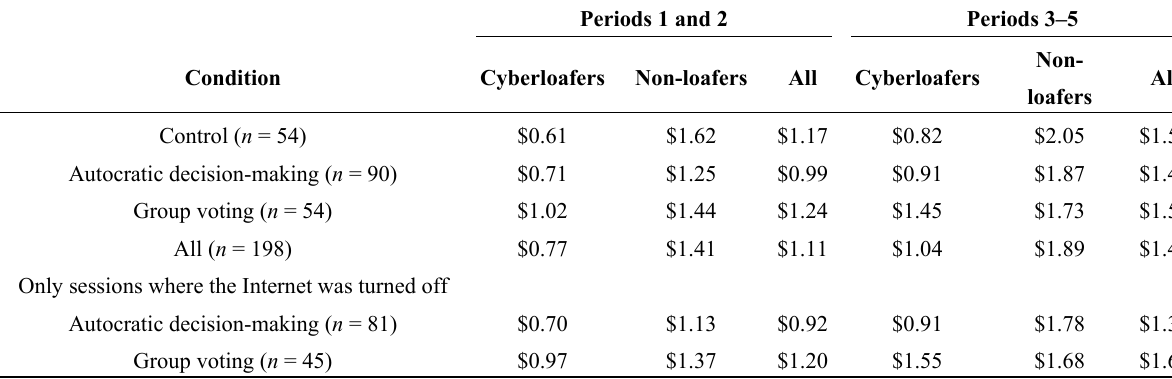
Table 3. Average individual production per period (in U.S. Dollars) across conditions (all workers, excluding the monitor; n denotes the number of workers per